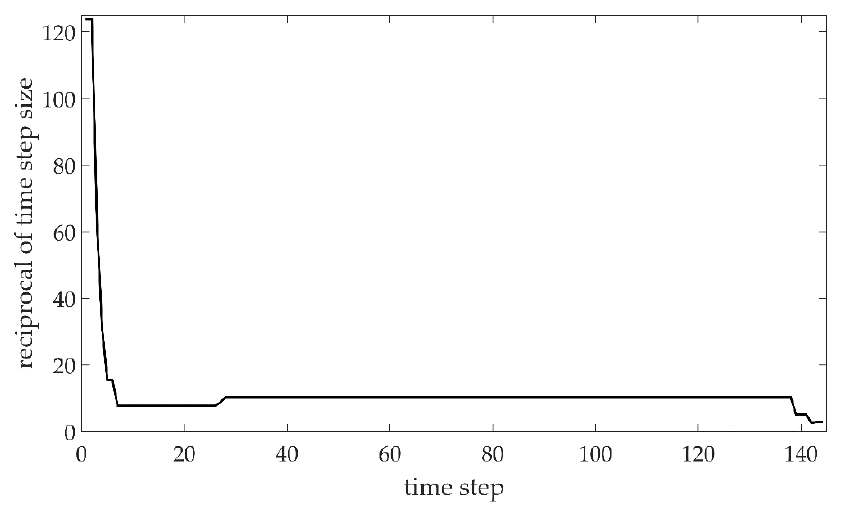
Figure 2. Reciprocal of the time step size versus the time step. Increasing time step sizes indicate good mesh convergence.